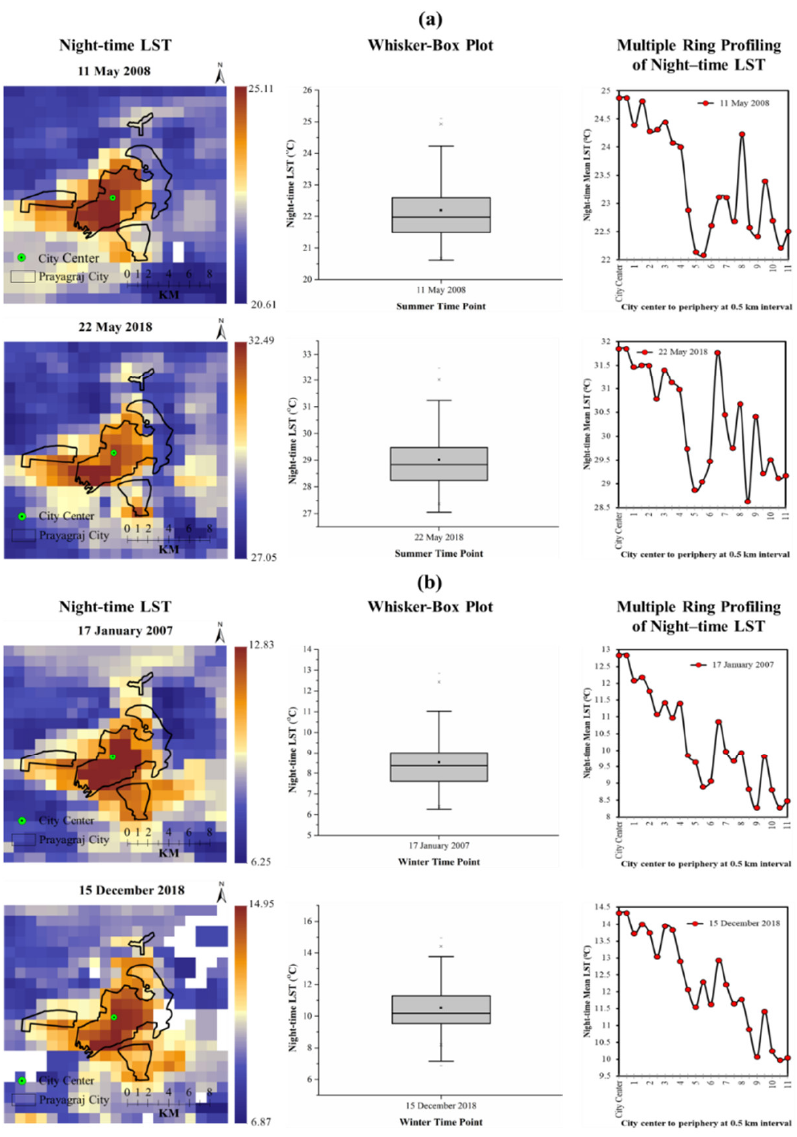
Figure 19. Maps of night-time LST dynamics with whisker boxplots for exploring SUHI at night-time: ( a ) summer and ( b ) winter.